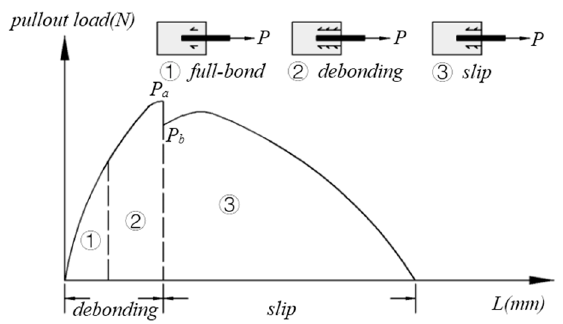
Figure 8. Image of a single fiber being pulled out.